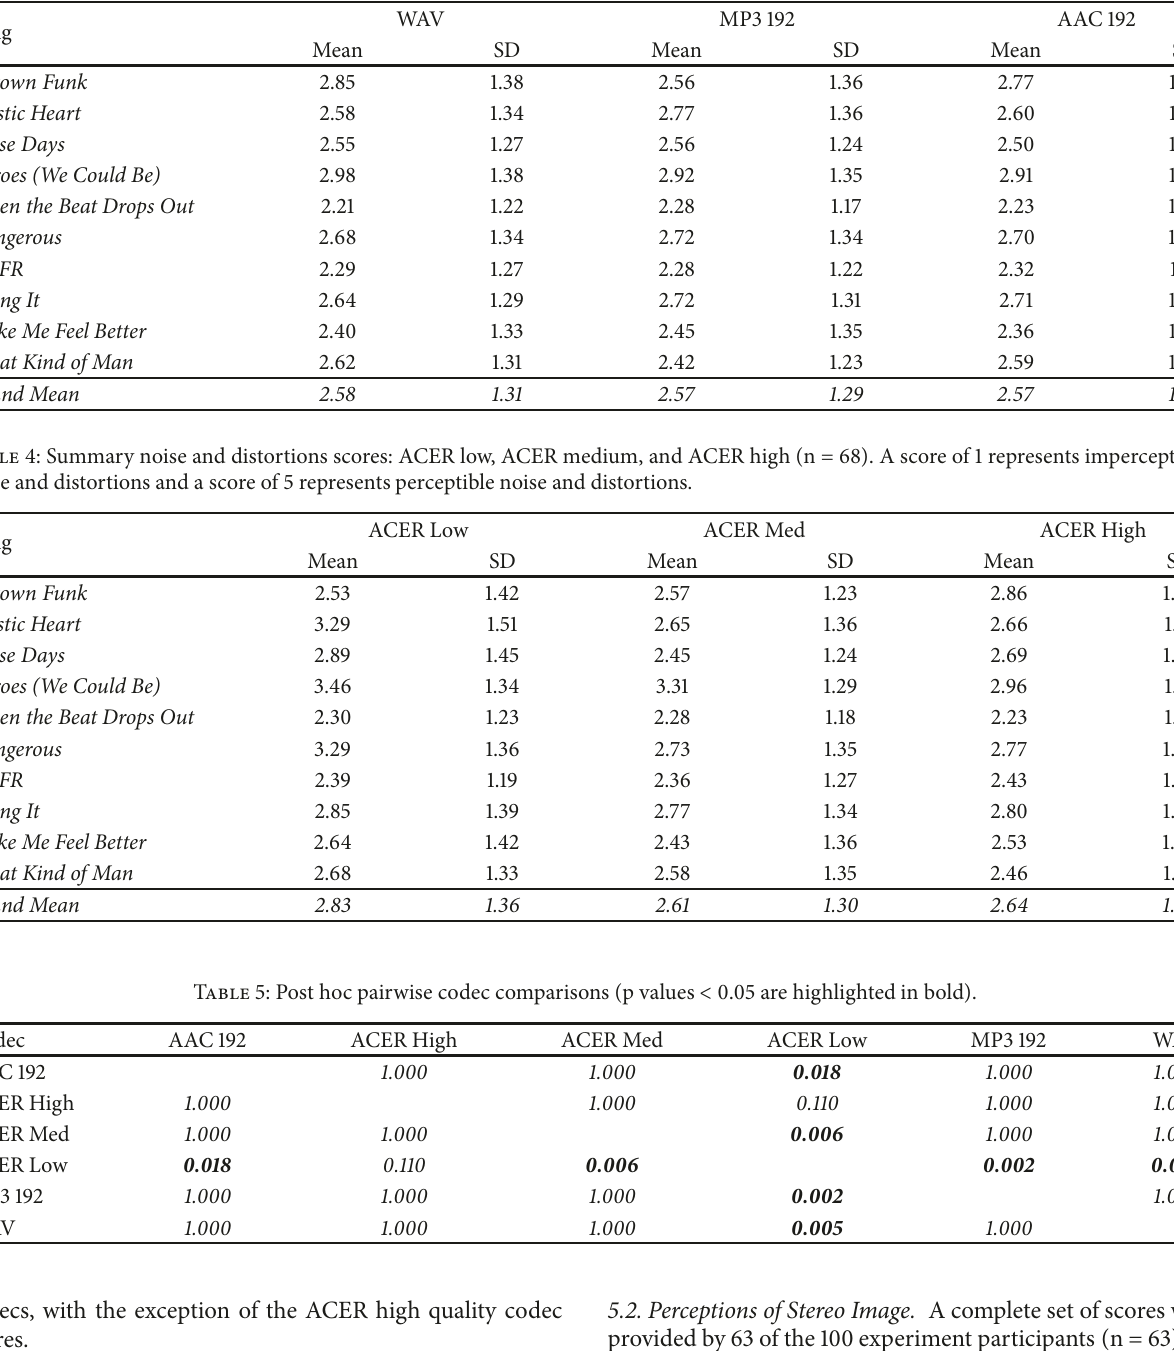
Table 3: Summary noise and distortions scores: WAV, MP3 192, and AAC 192 (n=68). A score of 1 represents imperceptible noise and distortions and a score of 5 represents perceptible noise and distortions.